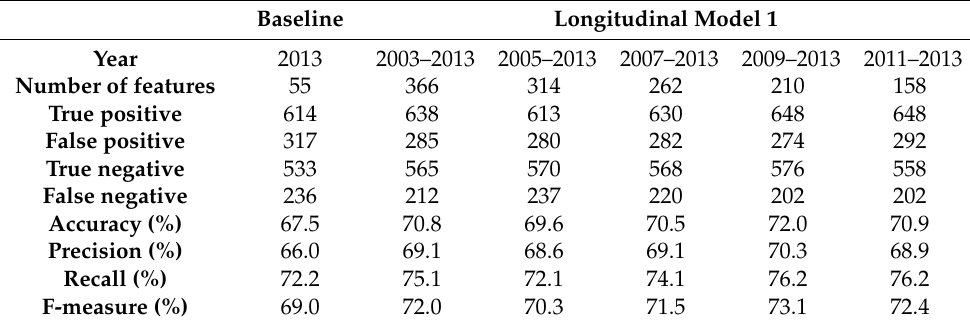
Table 8. Longitudinal model 1 (All MT-DB features with primary disease group).